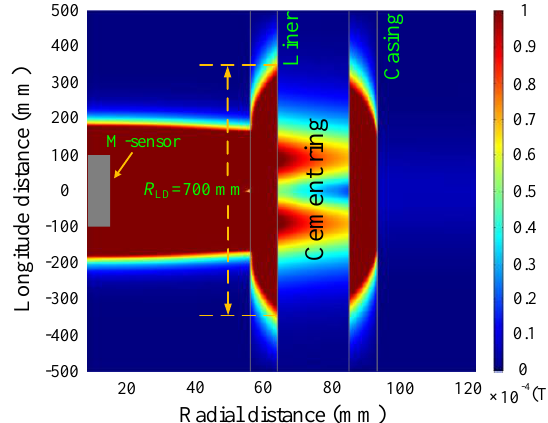
Figure 8. Eddy-current field of the main sensor at 50 ms.